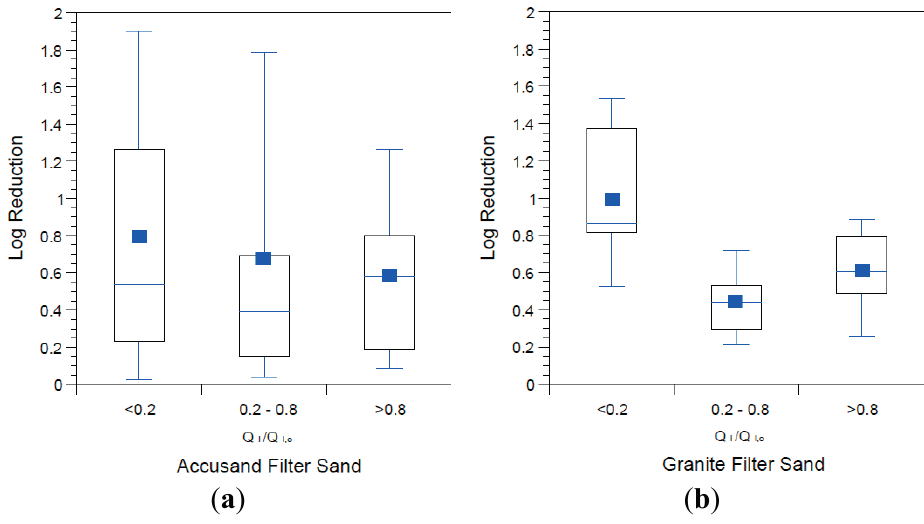
Figure 13. MS2 reductions for ( a ) Accusand media columns; and ( b ) granite